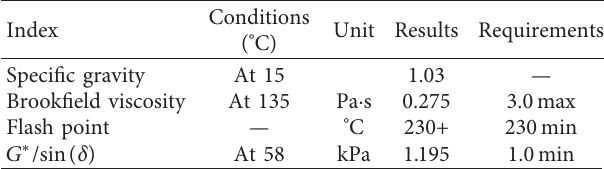
Table 2: Properties of original asphalt